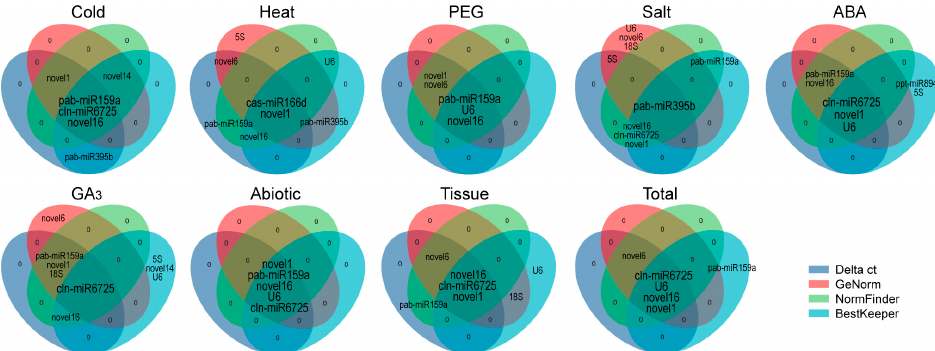
Figure 7. The top 5 most stable reference genes (RGs) were generated by delta-Ct, geNorm, NormFinder and BestKeeper. Blue, pink, green and sky-blue circles each contain the top 5 most stable RGs identified with delta-Ct, geNorm, NormFinder and BestKeeper, respectively. Genes in the overlapping area were confirmed as the top 5 most stable RGs by more than one algorithm.